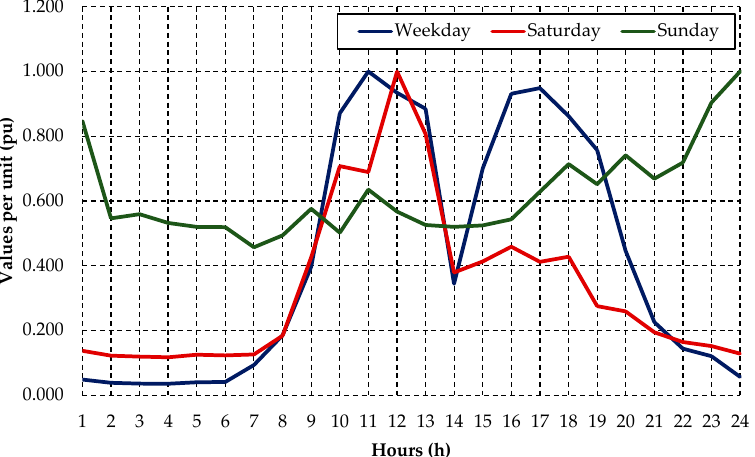
Figure 5. Typology of the daily load profile for an industrial customer. Source: The authors.